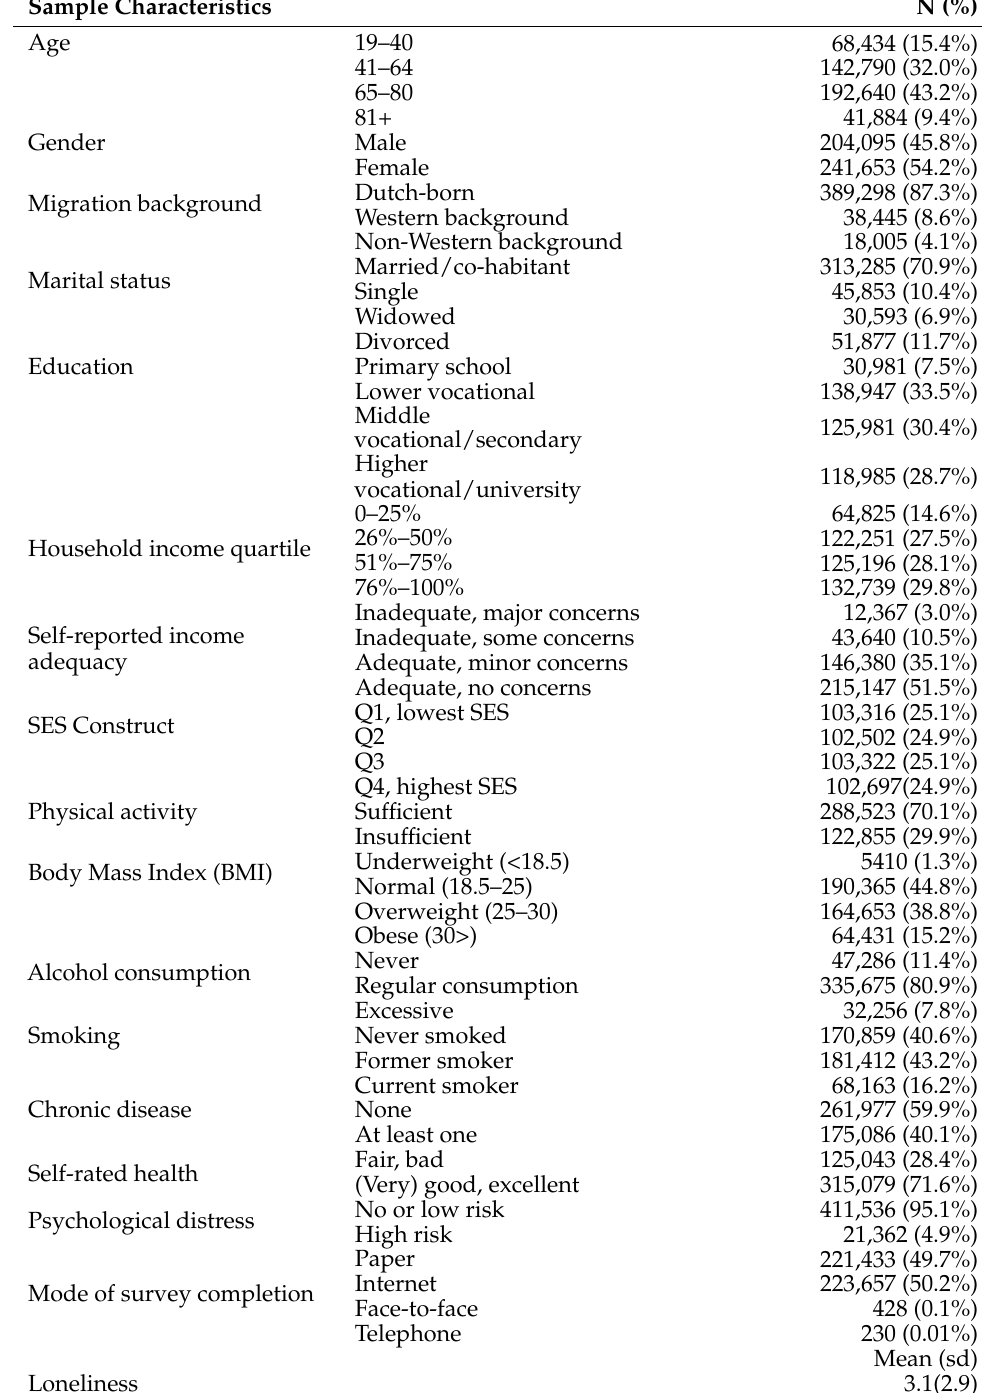
Table 1. Sample characteristics ( n =